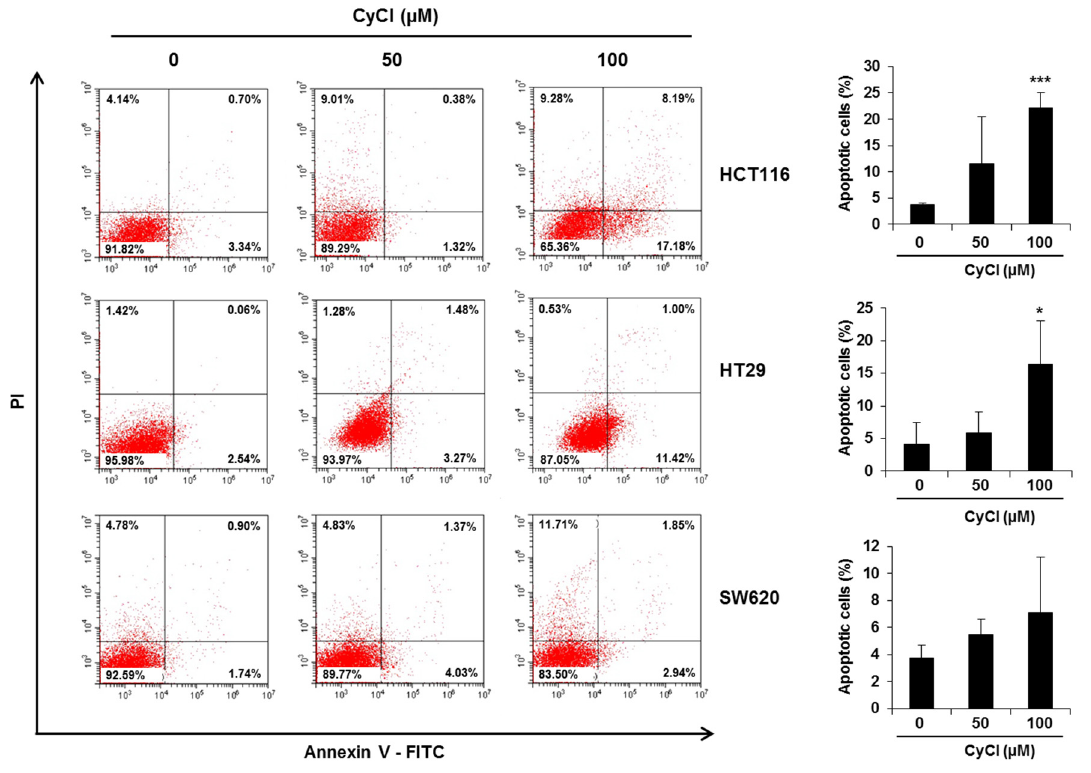
Figure 2. CyCl induces apoptosis in colon cancer cell lines. Cells were treated with 50 and 100 µM of CyCl for 24 h. The apoptotic rates were analyzed by flow cytometry using Annexin V-FITC/PI staining. Each experiment was performed in triplicate. * p < 0.05 and *** p < 0.001, significantly different compared with control.